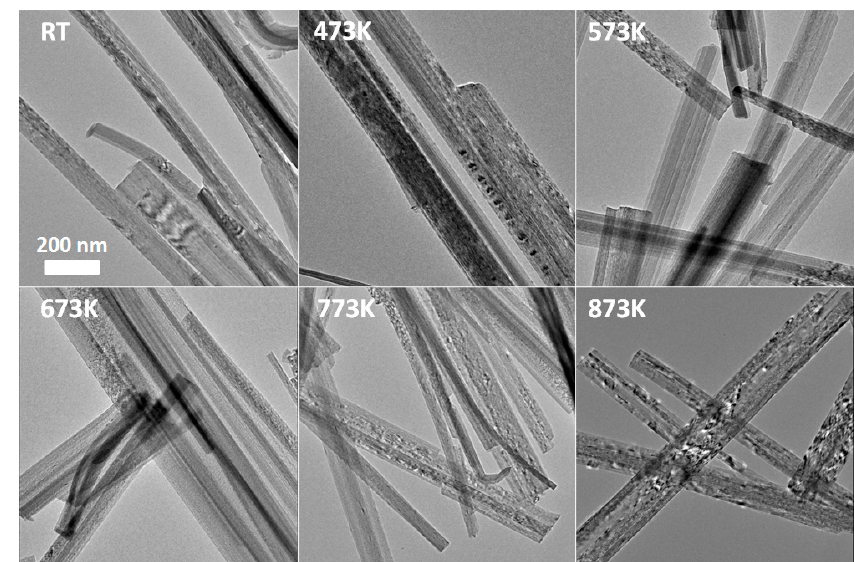
Figure 1. ( A ) XRD of TiONW treated at different temperatures. The bottom graph displays the XRD profile of H 2 O washed TiONW. • denotes anatase reflection ( B ) TEM images of TiONW treated at different temperatures. Reproduced from [70].